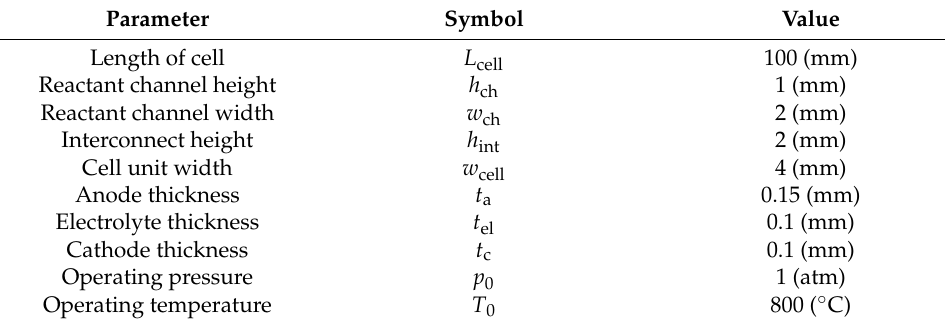
Figure 1. Numerical solid oxide fuel cell (SOFC) model. Table 1. Geometric and physical parameters of the model.